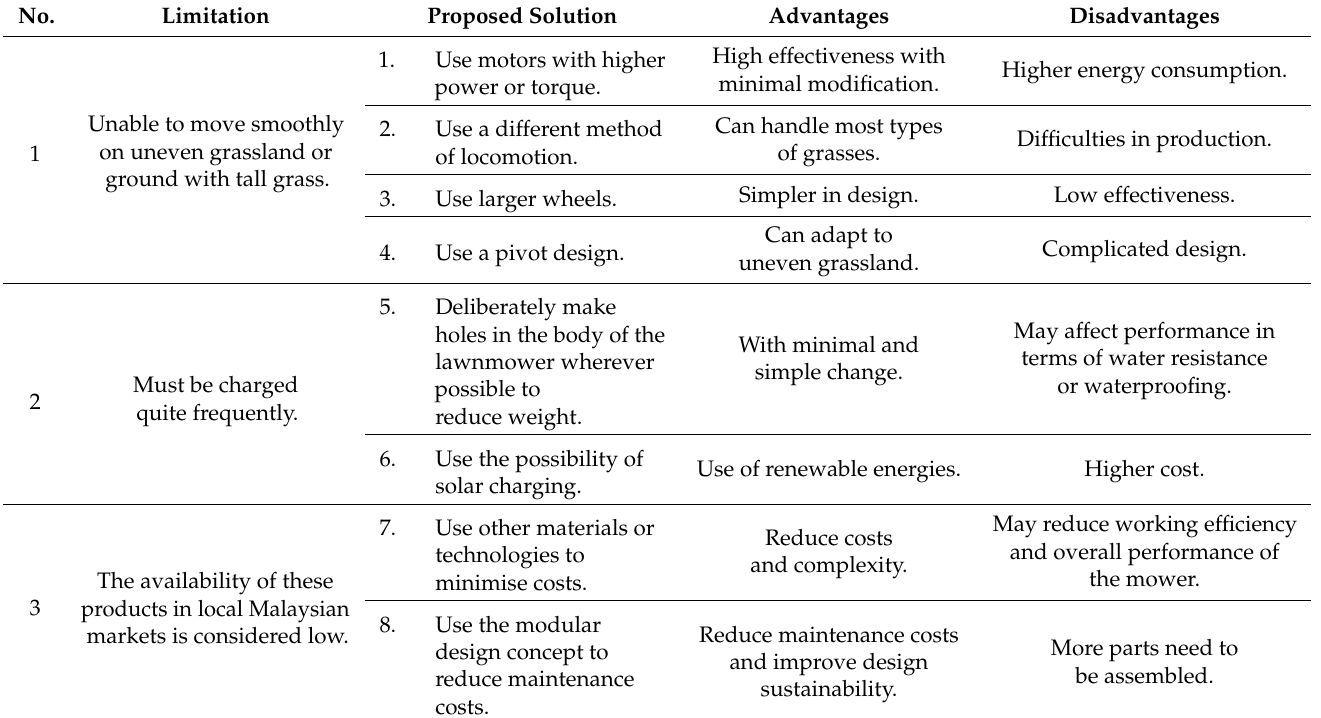
Table 14. List of proposed solutions from TRIZ methodology.